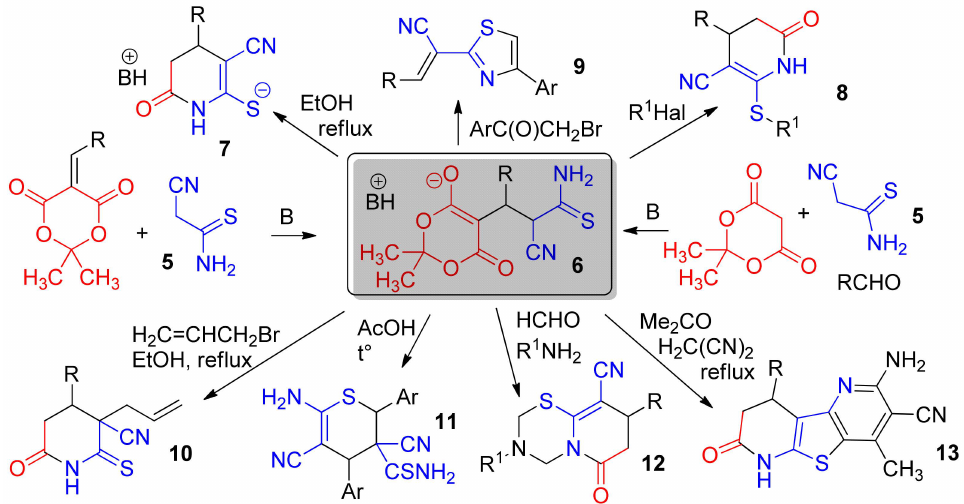
Scheme 2. Synthesis and reactions of the Michael adducts 6